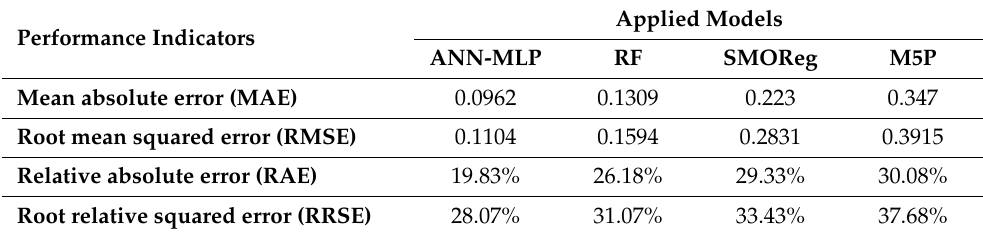
Table 2. Calculated statistical errors for various applied